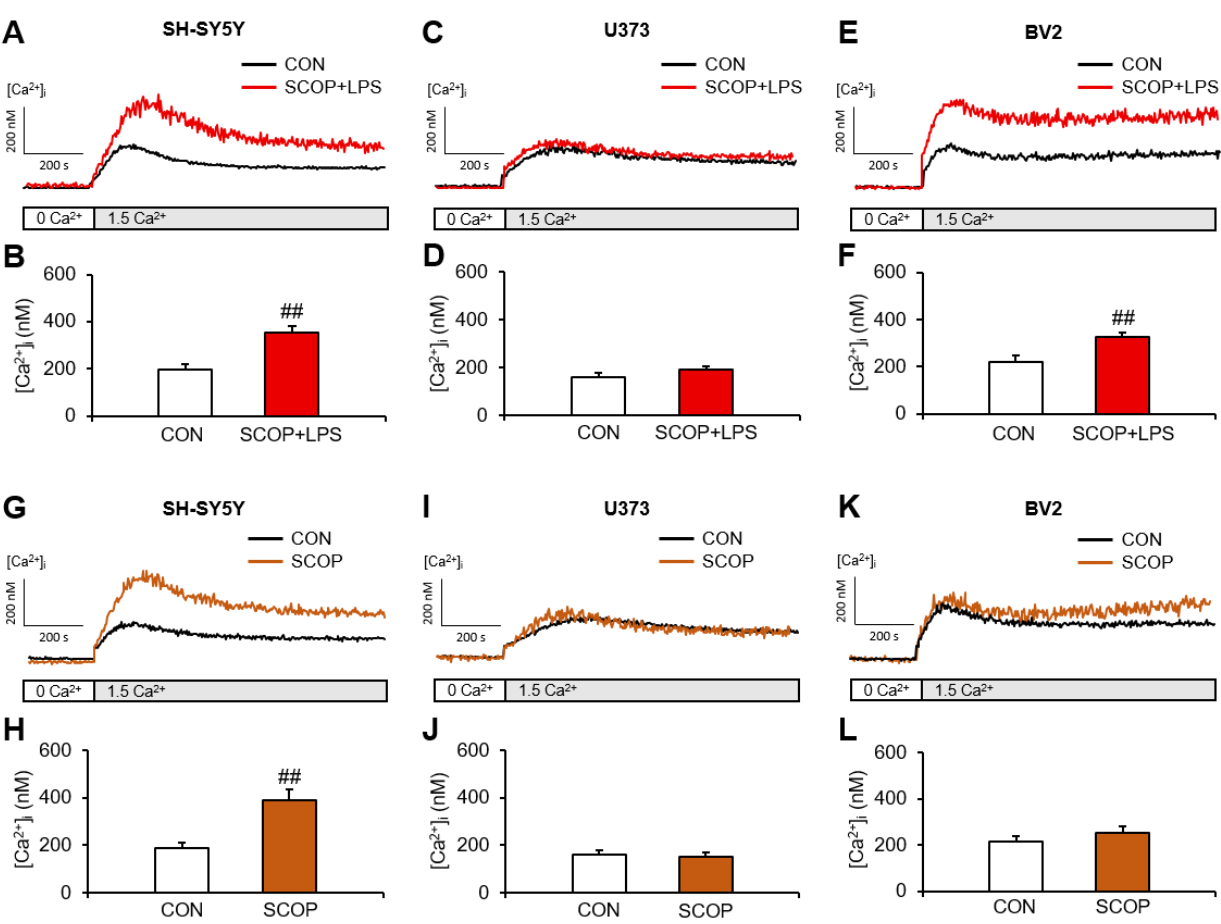
Figure 1. Comparison of store-operated Ca 2+ entry in SH-SY5Y, U373 and BV2 cells pretreated with scopolamine (SCOP) and treated with lipopolysaccharide (LPS), or treated with SCOP alone. Representative traces showing the effects of LPS in SCOP-pretreated ( A ) SH-SY5Y, ( C ) U373, and ( E ) BV2 cells. Summary data showing the peak [Ca 2+ ] i after adding 1.5 mM Ca 2+ to the ( B ) SH-SY5Y, ( D ) U373, and ( F ) BV2 cells. Representative traces showing effects of SCOP alone to the ( G ) SH-SY5Y, ( I ) U373, and ( K ) BV2 cells. Summary data showing the peak [Ca 2+ ] i after adding 1.5 mM Ca 2+ to the (H) SH-SY5Y, ( J ) U373 and ( L ) BV2 cells. Data are reported as means ± SEM ( n = 6–10; ## p < 0.01 vs. the control (CON) group.